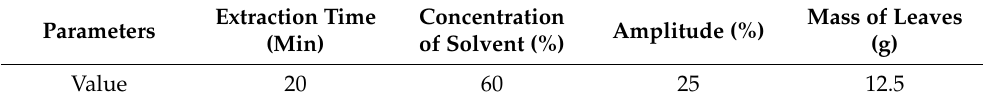
Table 4. Optimum conditions of ultrasonic extraction of yield of extract and 2AP from pandan leaves. Parameters